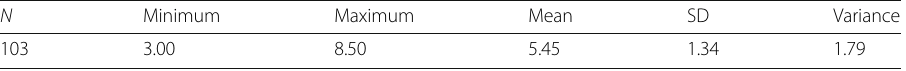
Table 5 Descriptive statistics of teachers ’ assessment of sample essay writing task